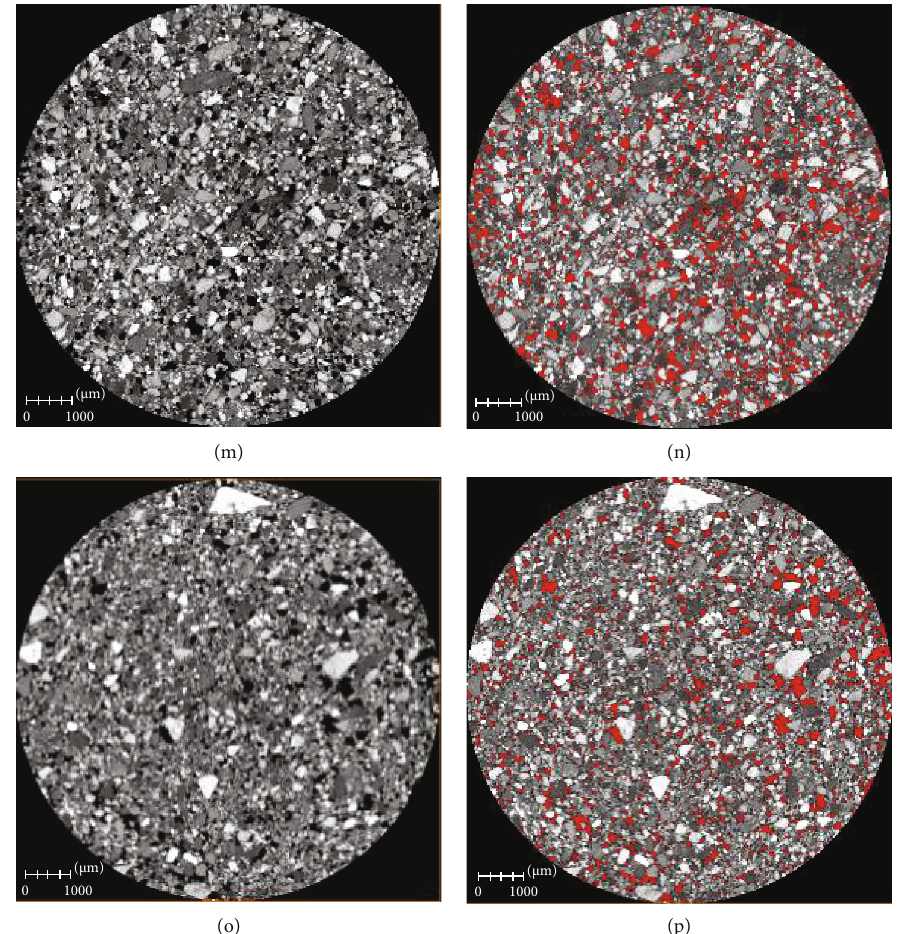
Figure 9: Tailing sand pore threshold segmentation. (a, b) q-1; (c, d) h-1; (e, f) q-2; (g, h) h-2; (i, j) q-3; (k, l) h-3; (m, n) q-4; (o, p)